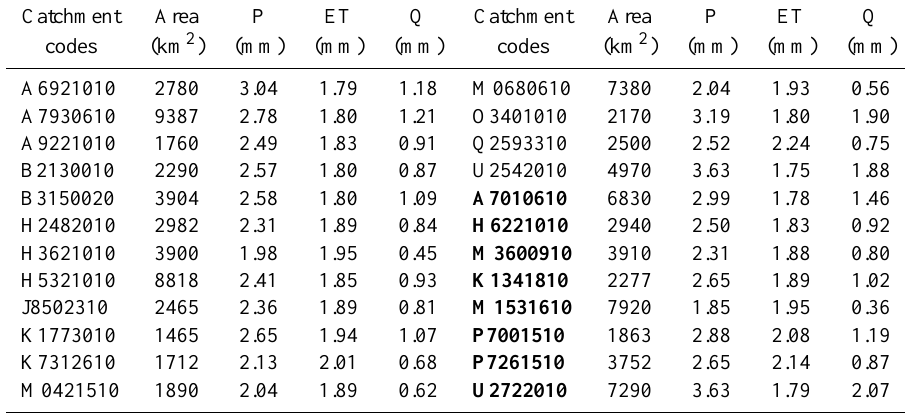
Table 1. Main characteristics of the studied basins (mean annual values) based on a 36 year length of the series (1970–2006).